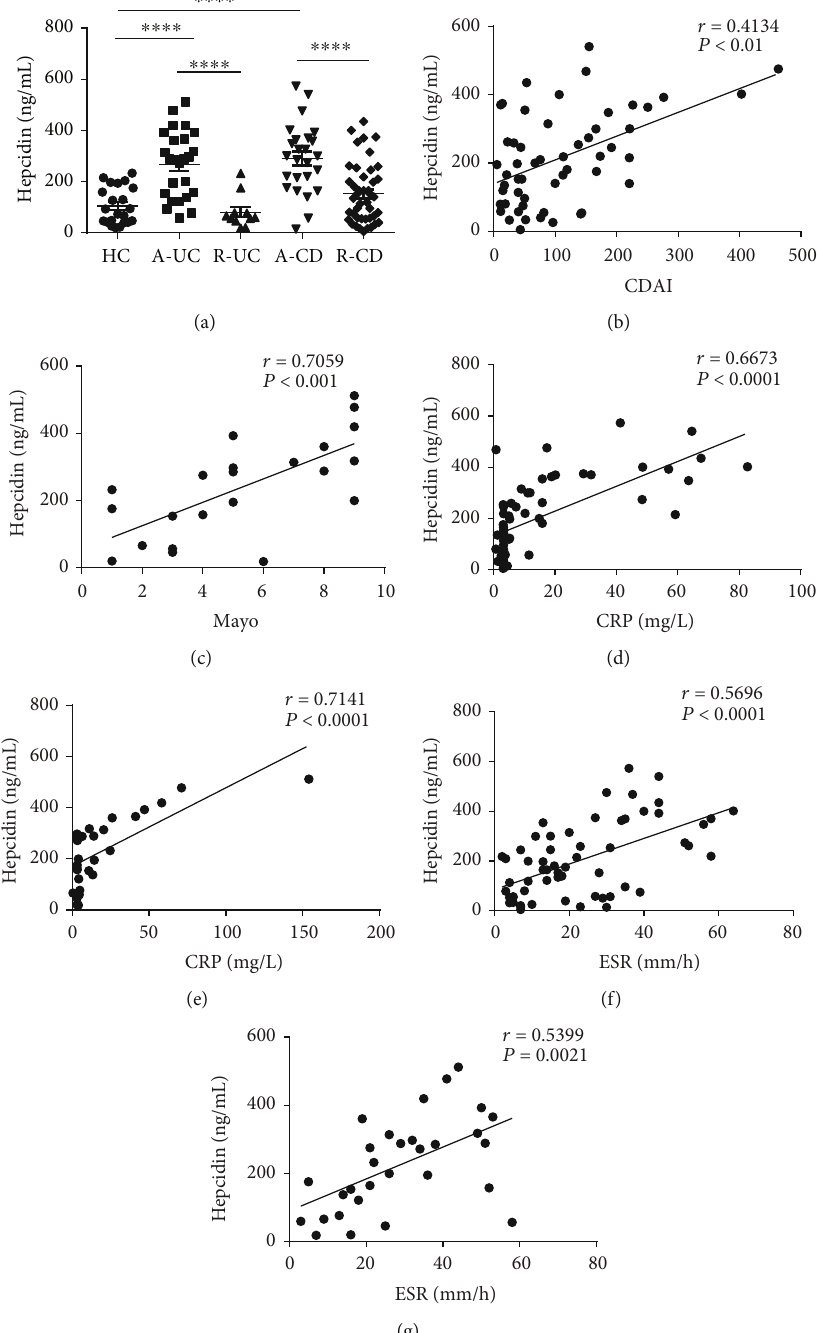
Figure 1: Hepcidin is increased in the sera of IBD patients and associated with disease activity, C-reactive protein (CRP), and erythrocyte sedimentation rate (ESR), respectively. (a) Serum samples were collected from healthy control (HC, n = 22 ), active CD patients (A-CD, n = 25 ), CD patients in remission (R-CD, n = 41 ), active UC patients (A-UC, n = 22 ), and UC patients in remission (R-UC, n = 11 ), and hepcidin was analyzed by ELISA. ∗∗∗∗ P < 0 : 0001 , ∗∗∗ P < 0 : 001 . Data were expressed as mean ± SEM , unpaired Student ’ s t -tests. (b) Correlation between Crohn ’ s disease activity index (CDAI) and hepcidin in patients with CD ( n = 54 ). (c) Correlation between Mayo score and hepcidin in patients with UC ( n = 22 ). (d) Correlation between CRP and hepcidin in patients with ( n = 60 ). (e) Correlation between CRP and hepcidin in patients with UC ( n = 29 ). (f) Correlation between ESR and hepcidin in patients with CD ( n = 60 ). (g) Correlation between ESR and hepcidin in patients with UC ( n = 30 ). Correlation analysis was performed by Spearman ’ s correlation analysis. P values are shown in each